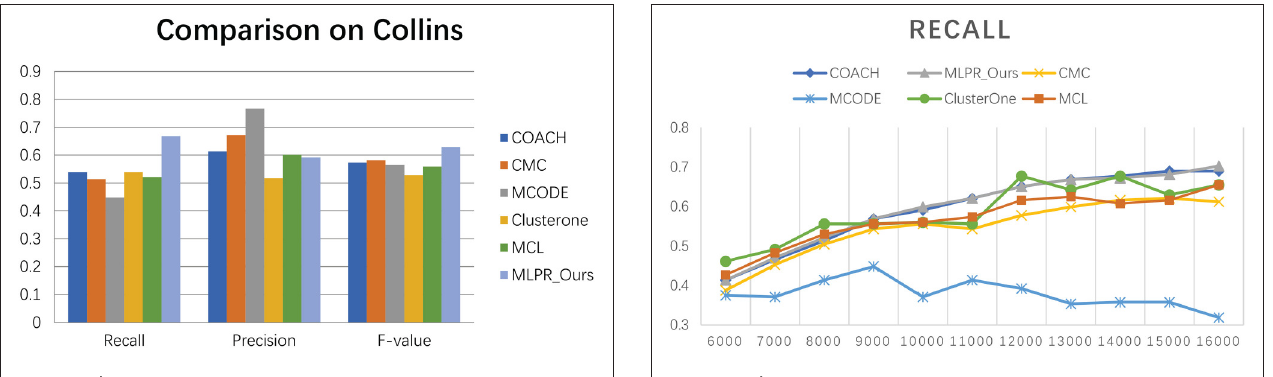
FIGURE 12 | The recall of our method and other five methods on our reconstructed